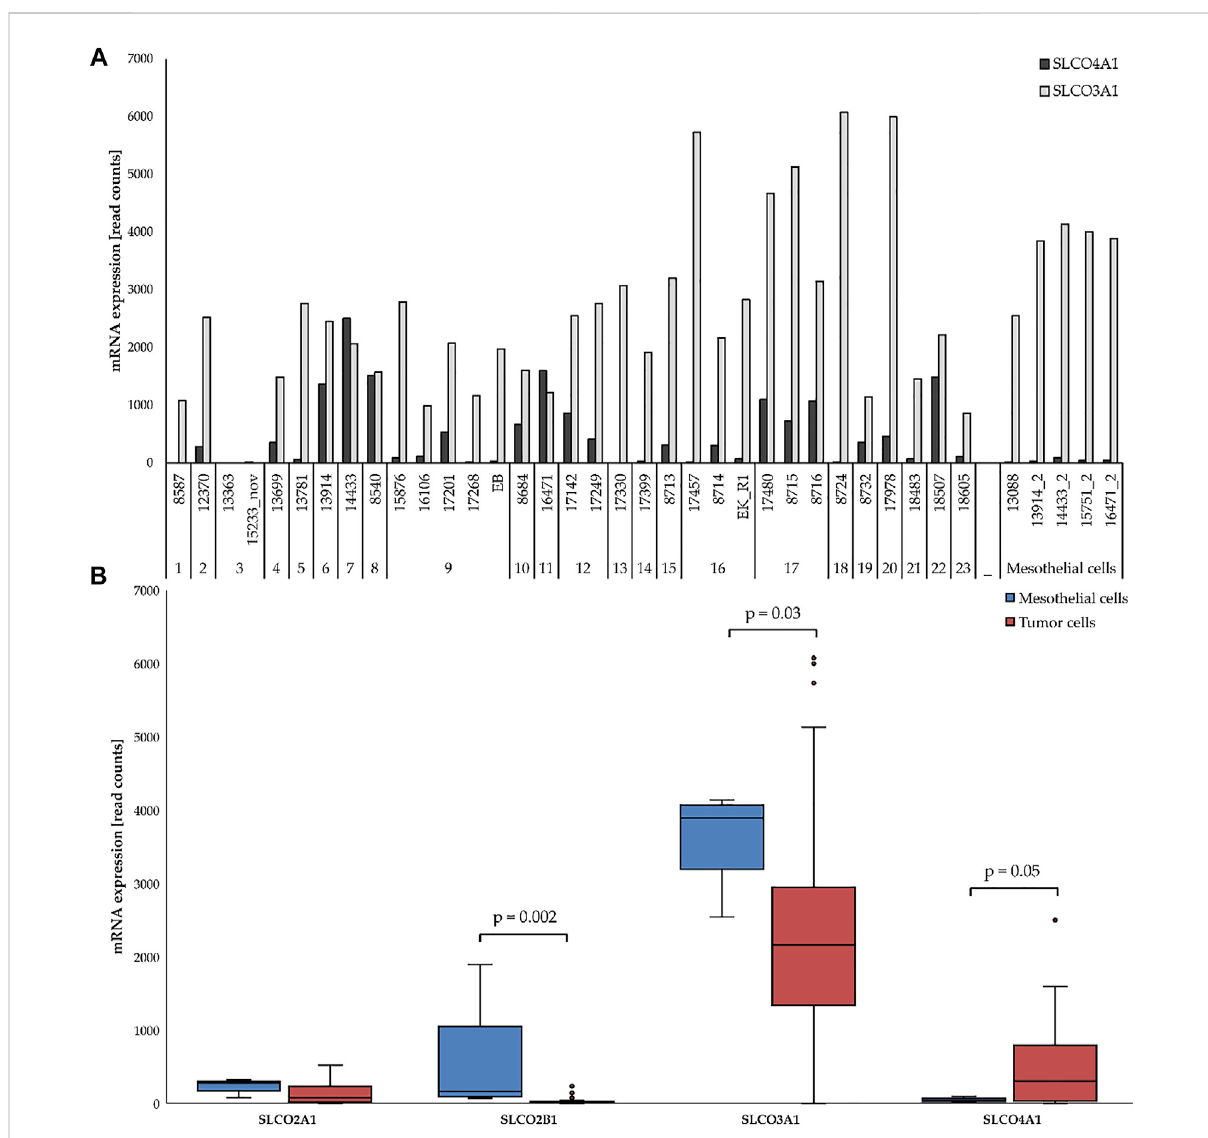
FIGURE 1 mRNAexpressionofselectedSLCOsinovariancancercelllines(red)andmesothelialcells(blue). (A) SLCO4A1andSLCO3A1levelsin5mesothelialand 33ovariancancercelllinesfromHGSOCpatients.Celllinesandthecodeforeachpatientareindicatedatthebottom. (B) ExpressionofSLCO4A1andthree othergenesintheovariancancer(red)andmesothelial(blue)group.Boxesincludealldatafromthe fi rsttothirdquartile,withtheindicatedmedian.Theupper and lower lines indicate the maximum and minimum values excluding any outliers. Outliers are indicated as dots. Statistical signi fi cance ( p <